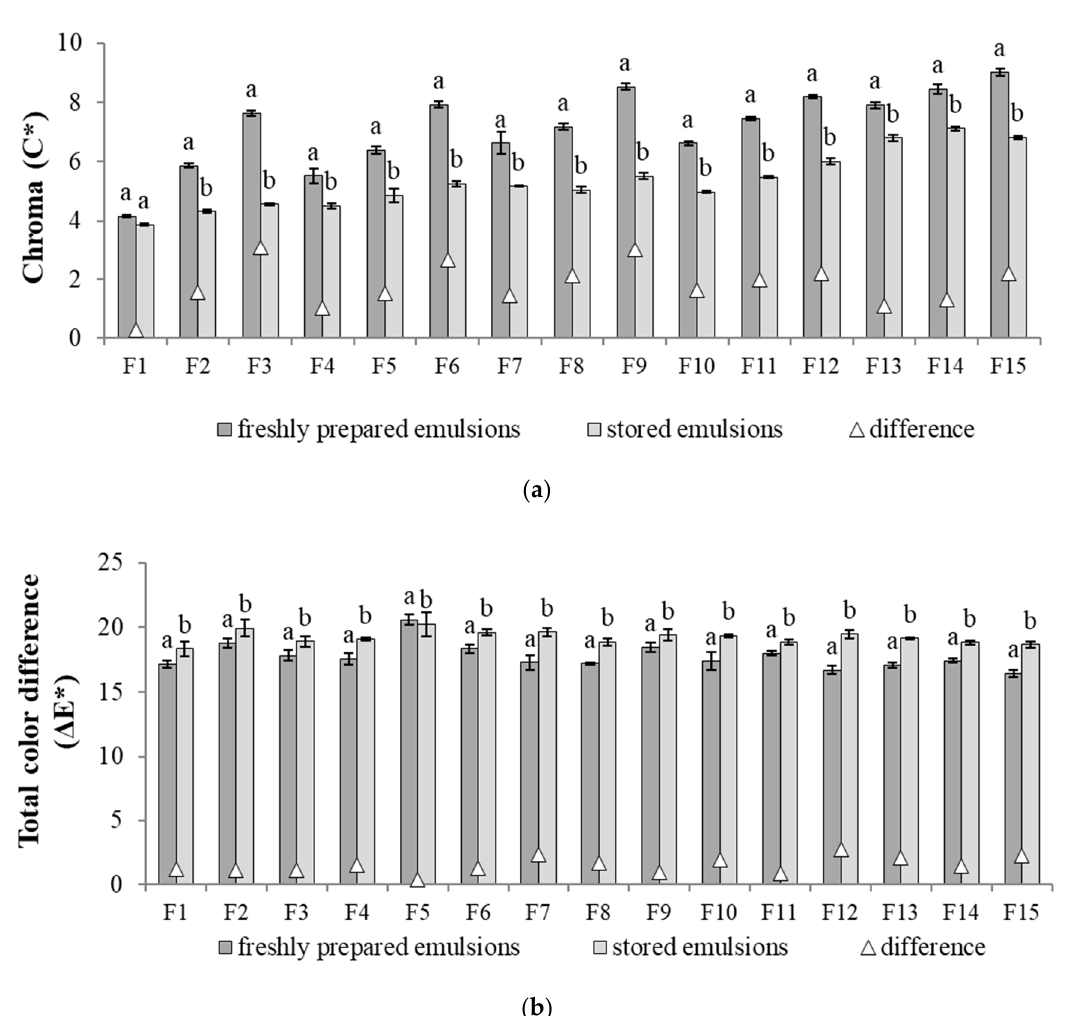
Figure 3. Emulsion color assessment ( a ) Chroma (C*); ( b ) Total color difference ( ∆ E*). a, b—different letters for the same parameter after storage period (i.e., C* for freshly prepared and C* for stored emulsions, etc.) indicate significantly different values ( p < 0.05).